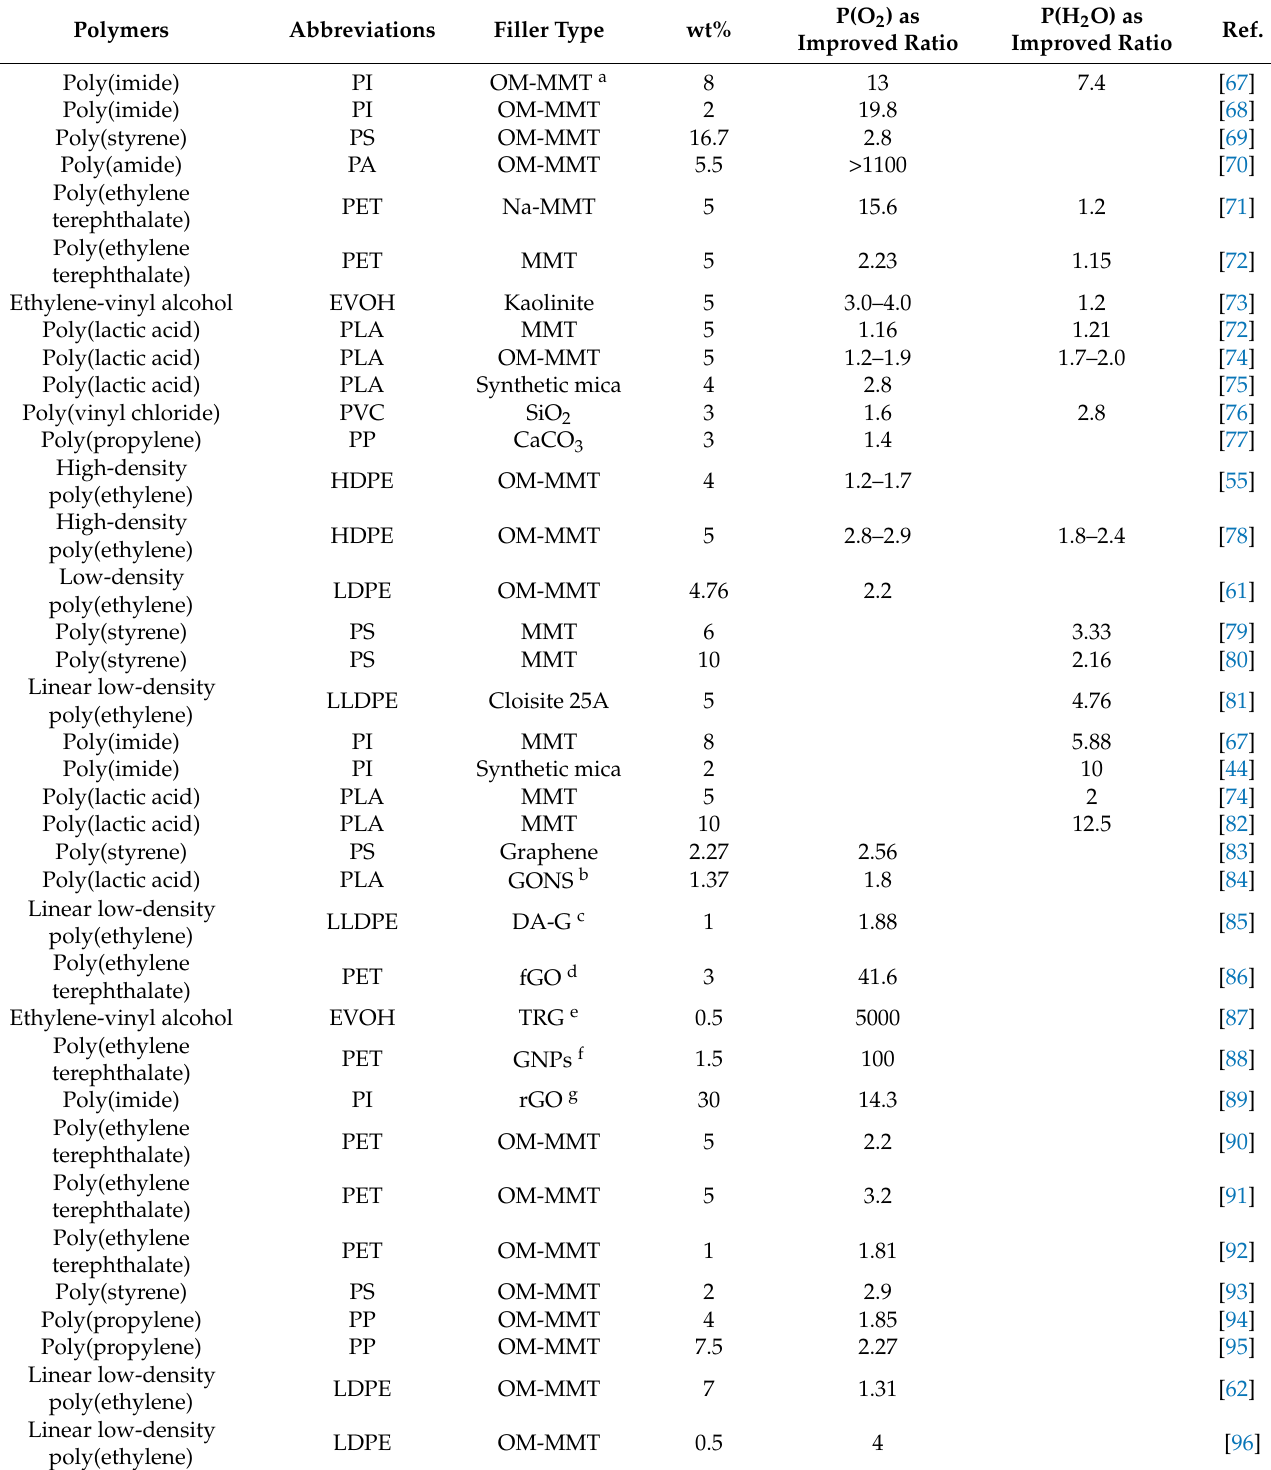
Table 1. Examples of polymer nanocomposites and the changes in their barrier properties expressed as an improved ratio in permeability, summarized from [1,7–11]. a Organo-modified montmorillonite, b graphene oxide nanosheet, c dodecyl amine-modified graphene, d functionalized graphene oxide, e thermally reduced graphene, f graphite nanoplatelets, g reduced graphene